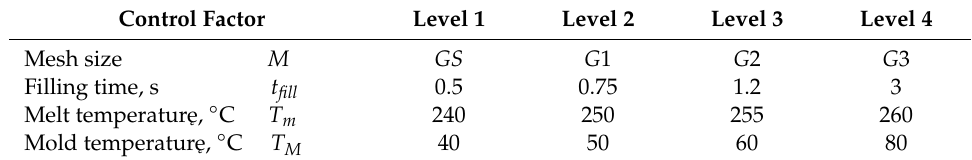
Table 3. Specified range of control factors (optimized process parameters) for Taguchi method.